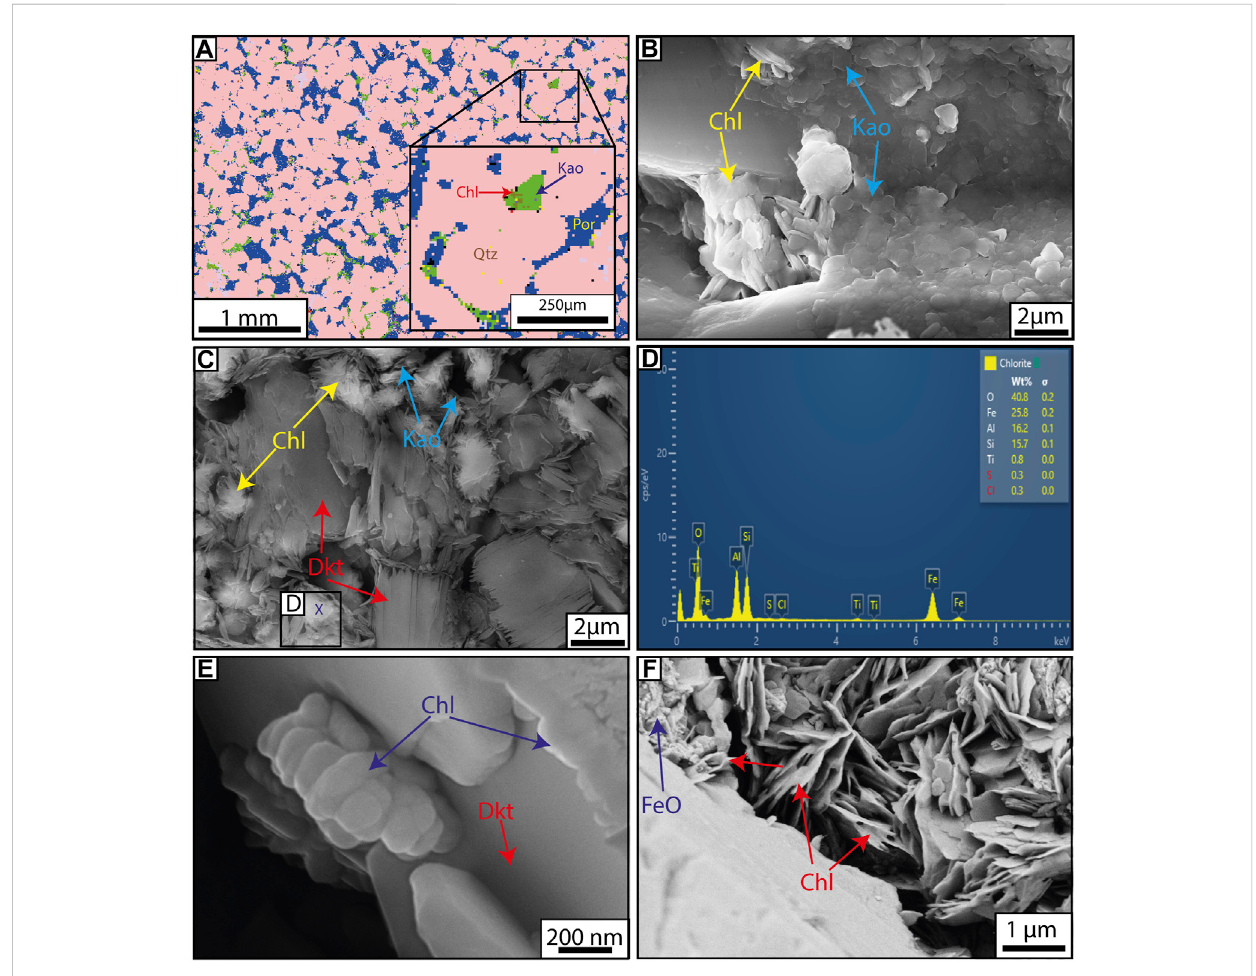
FIGURE 10 Mode of occurrence and morphologies of chlorite in the sandstones. (A) QEMSCAN image showing close association between kaolinite (Kao) and chlorite (Chl). They grow between detrital quartz (Qtz) and within the pore (Por). (B) Chlrorite (Chl) replacing the disrupted crystals of kaolinite (Kao). (C) Chlorite (Chl) replacing kaolinite crystals, with dickite (Dkt) remaining completely unreplaced. (D) EDS analysis of the identi fi ed chlorite in (C) . (E) Rosette chlorite (Chl) growing on dickite (Dkt). (F) Chlorite (Chl) occurring between dissolved FeO